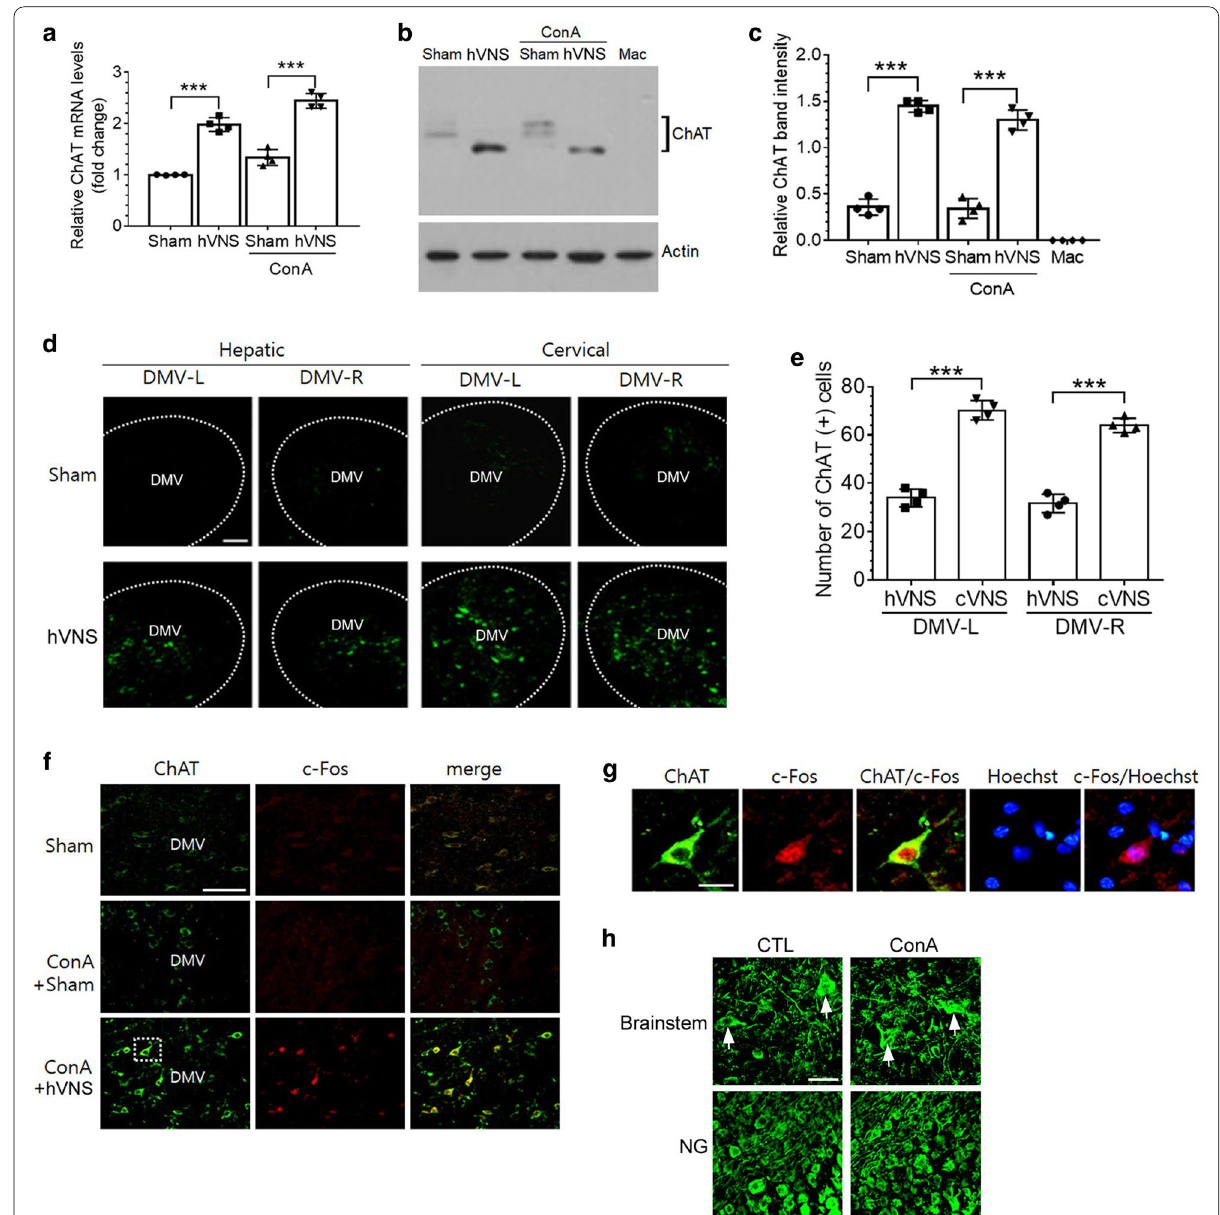
Fig. 5 Induction of ChAT expression by hVNS in DMV brain tissues. a Quantification of ChAT mRNA by real‑time PCR. b , c Western blot analysis of ChAT protein. Images in b are the representative from four independent experiments. Quantification of ChAT protein band intensity relative to actin is plotted in c . d – g Immunofluorescence staining of ChAT/c‑Fos proteins in the brain tissues. d Representative images showing ChAT signals in the left (L) and right (R) sides of DMV areas in groups of animals given VNS at the hepatic branch or at the cervical location along with corresponding Sham treatments. e Quantification of the number of ChAT‑positive cells in the DMV after hepatic VNS (hVNS) and cervical VNS (cVNS). f Immunofluorescence images of ChAT/c‑Fos in the brainstem sections. Both ChAT and c‑Fos signals were clearly detected from neurons in the left side of DMV of ConA hVNS group of animals. g Enlarged images of the dotted rectangular area of ConA hVNS animal in f showing + + the colocalization of ChAT and c‑Fos signals. Note intense c‑Fos signal in the nucleus identified by Hoechst staining (blue). h Immunofluorescence staining of neurons in the DVC area in the brainstem and the nodose ganglion (NG) with anti‑NF‑200 antibody. a , c , e , one‑way ANOVA with Tukey post hoc is shown. ***p < 0.001 (n 4). Scale bars in d and f , g , and h are 100 μm, 20 μm, and 50 μm, =